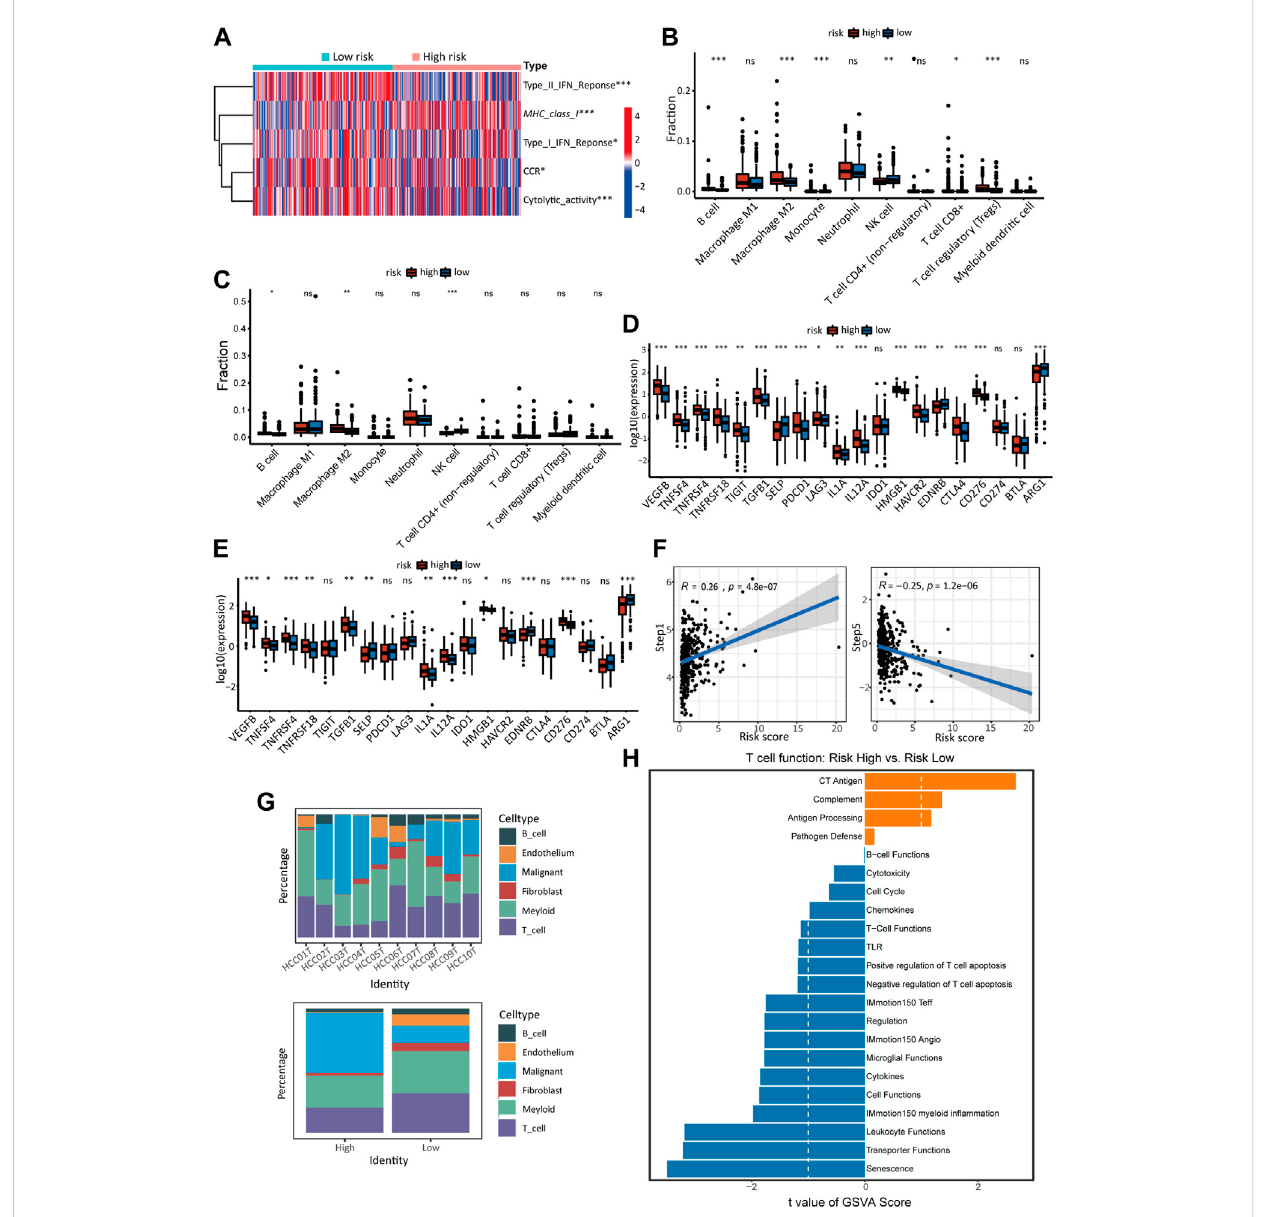
FIGURE 6 The immune landscape of high- and low-risk groups. (A) Heatmap of ssGSEA scores in the activity of immune-related processes in TCGA cohort. Thequantiseqmethodcalculatestheproportion of10types ofimmune cellsinlow- andhigh-riskscore groupsoftheTCGA cohort (B) andICGCcohort (C) . The expression of immune checkpoints in the high-risk and low-risk groups of the TCGA cohort (D) and ICGC cohort (E) . (F) Correlation between cancer-immunity cycle scores and risk scores in the model in the TCGA cohort. (G) The proportion of malignant cells and immune-related cells in high-risk and low-risk samples of single-cell sequencing data. Detailed data was shown in supplementary Table S1 (S4). (H) GSVA analysis of T cell function in the single-cell